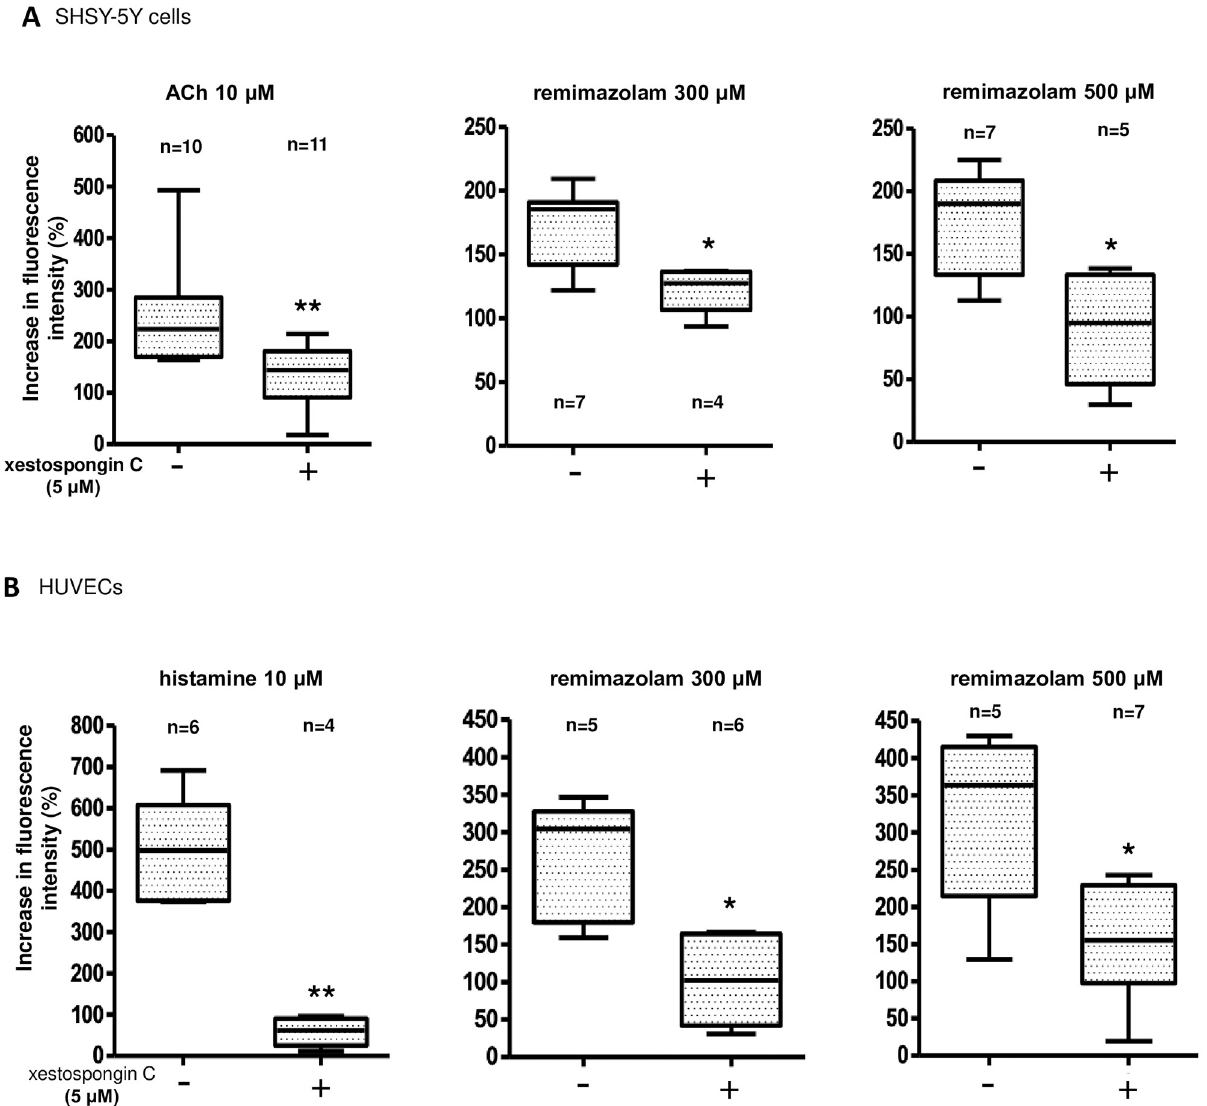
Fig 7. Characterization of remimazolam-induced calcium elevation; possible involvement of the IP 3 receptors. (A) Fifteen minutes-pretreatment with Xestospongin C (Xc), an inositol 1,4,5-triphosphate receptor (IP 3 R) antagonist, at 5 μ M significantly inhibited the ACh 10 μ M-induced calcium elevation in SHSY-5Y cells (n = 10–11, �� p = 0.0035, compared to control, Mann Whitney test). Similarly, 15 minutes-pretreatment with Xc at 5 μ M affected 300 and 500 μ M remimazolam-induced calcium elevation in SHSY-5Y cells (n = 4–7, � p = 0.0242, compared to control, Mann Whitney test, and n = 5–7, � p = 0.0177, compared to control, Mann Whitney test, respectively). The horizontal line in each box indicates the median, the box shows the interquartile range (IQR), and the whiskers represent 1.5 × IQR. (B) Fifteen minutes-pretreatment with Xestospongin C (Xc) at 5 μ M significantly inhibited the histamine 10 μ M-induced calcium elevation in HUVECs (n = 4–6, �� p = 0.0095, compared to control, Mann Whitney test). Similarly, 15 minutes-pretreatment with Xc at 5 μ M affected 300 and 500 μ M remimazolam-induced calcium elevation in HUVECs (n = 5–6, � p = 0.0173, compared to control, Mann Whitney test, and n = 5–7, � p = 0.0303, compared to control, Mann Whitney test, respectively). The horizontal line in each box indicates the median, the box shows the interquartile range (IQR), and the whiskers represent 1.5 ×